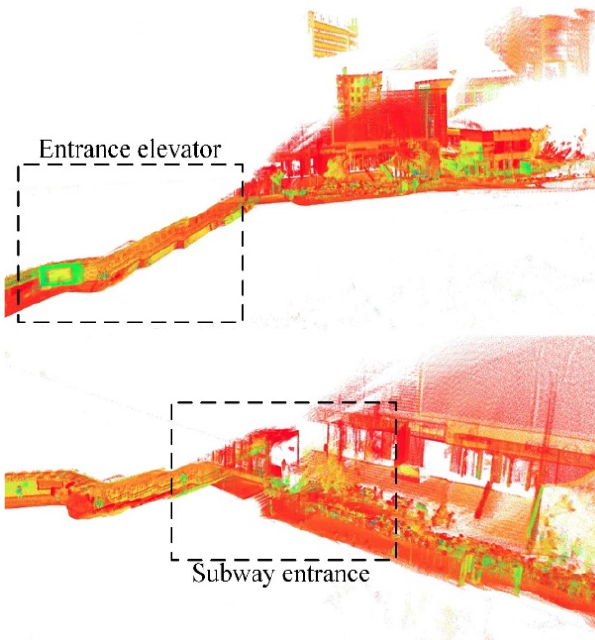
Figure 8. Walking out of the metro station.